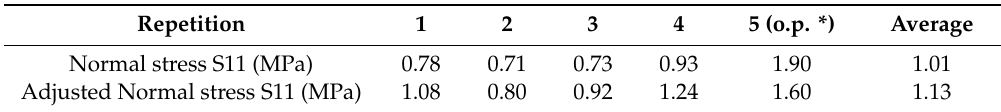
Figure 12. Normal stress S11 in the ice layer for first test with all actuators in phase for mode 5, top view ( a ) and side view ( b ). Table 11. Normal stress S11 and adjusted normal stress S11 calculated by the numerical model for all repetitions performed experimentally for mode 5.